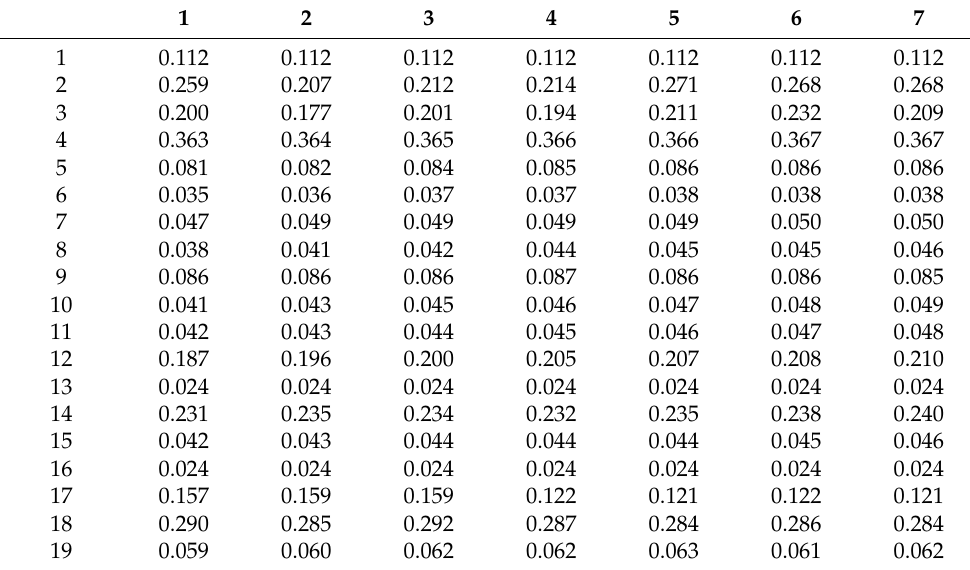
Table A4. Short-term prediction error (RMSE) of the trivial median model—application to 19 tanks, 7-day prediction